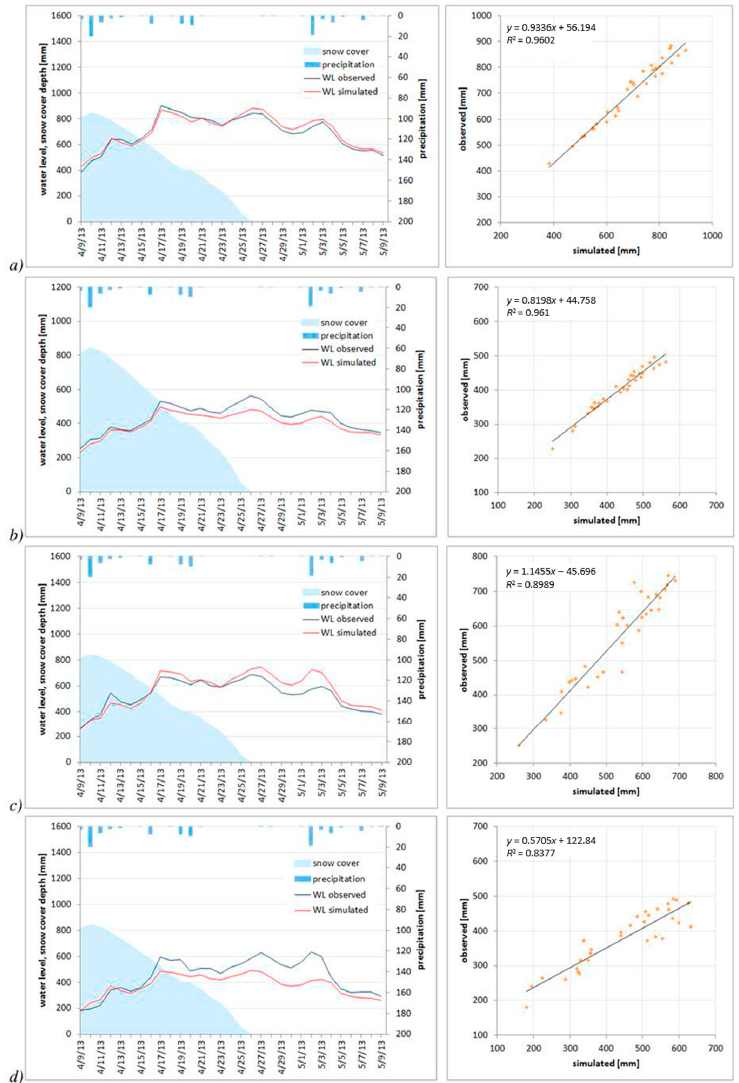
Figure 9. Simulation scenario SC3—snowmelt in late spring during 9 April–9 May 2013 at stations: ( a ) RKM; ( b ) JAV; ( c ) ROK; and ( d ) HAJ.